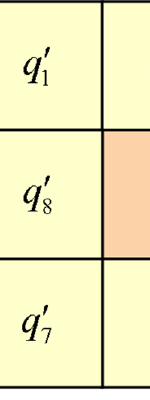
Figure 5. The eight neighbors of grids.